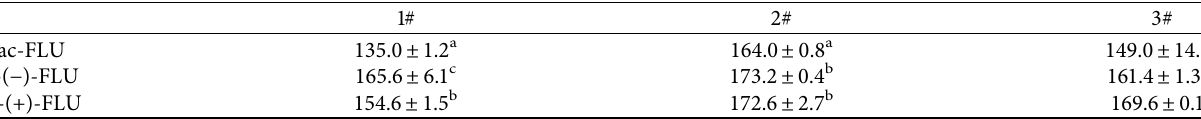
Table 2: Adsorption capacity (mg/kg) of FLU enantiomers in diferent sediment samples. Error bars are the standard deviations of the means of adsorption tests on three replicates.